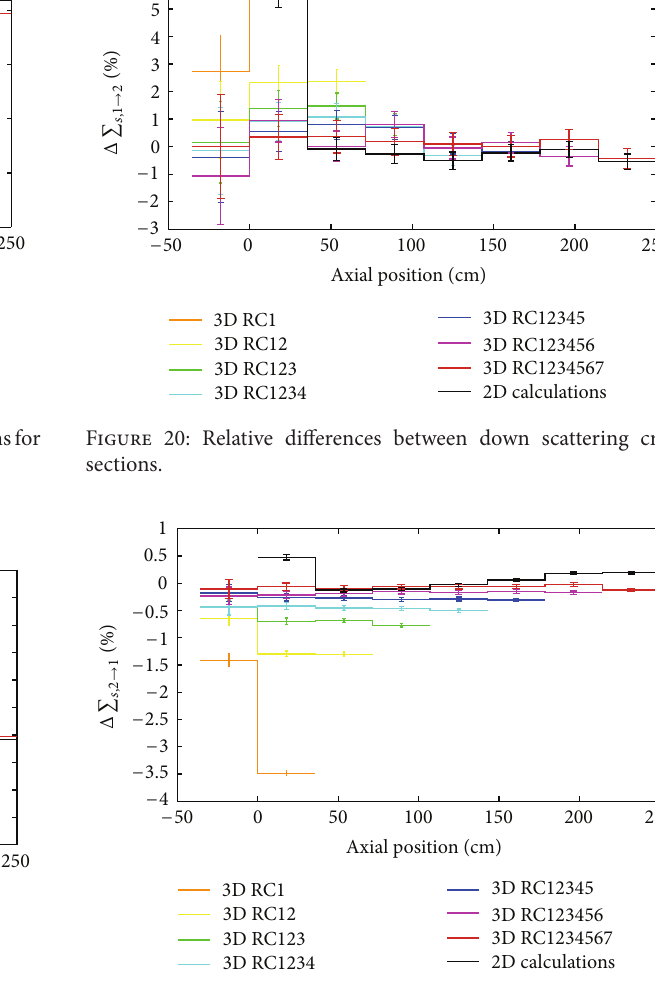
Figure 21: Relative differences between up scattering cross